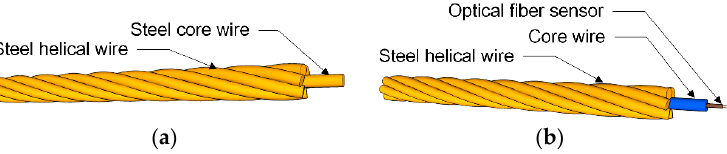
Figure 1. Shape and composition of conventional and smart strands: ( a ) Conventional strand; ( b ) Smart strand.